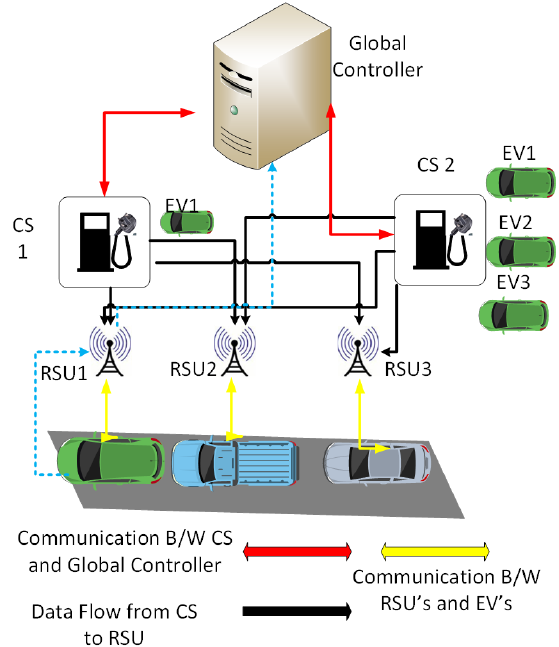
Figure 6. Communication Network Infrastructure of EV Charging